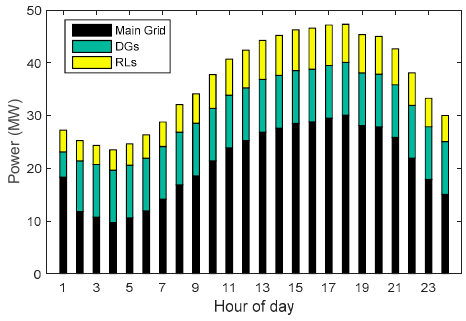
Figure 7. Energy resources scheduling result for Case 3.